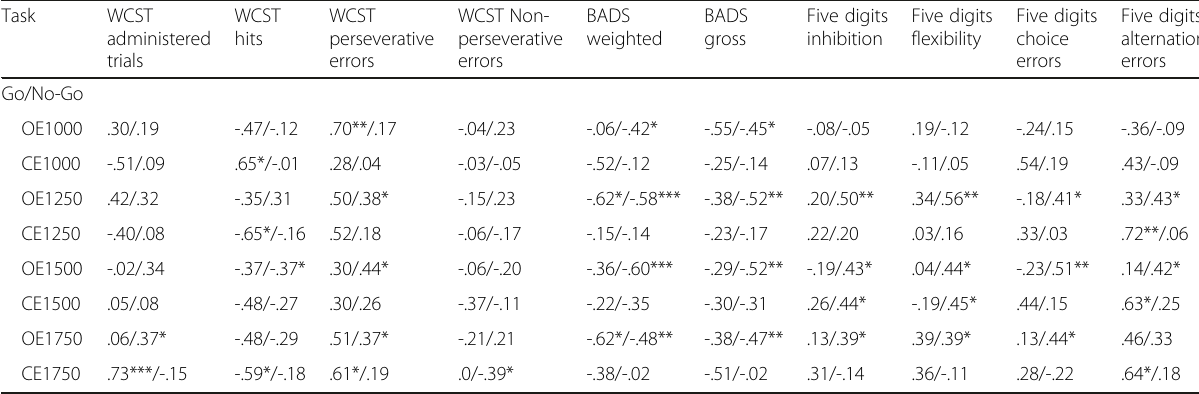
Table 4 Correlation measures among impulsivity behavioral tasks and executive functions evaluation tests for both clinical groups Task Five digits